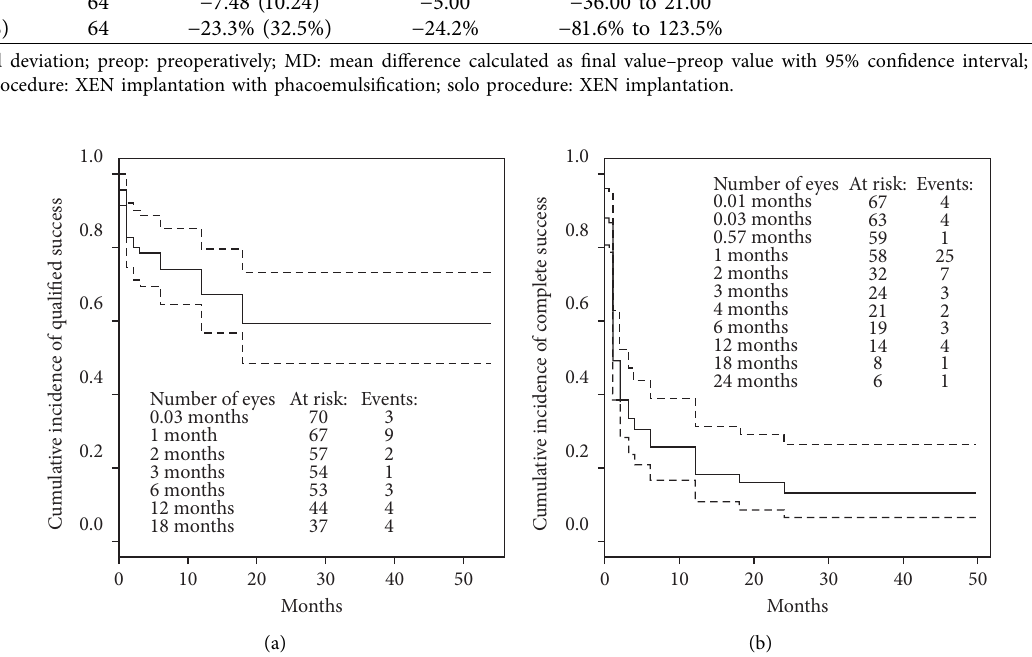
Figure 1: Kaplan–Meier cumulative incidence of qualified success and complete success. The dotted lines indicate 95% confidence interval.